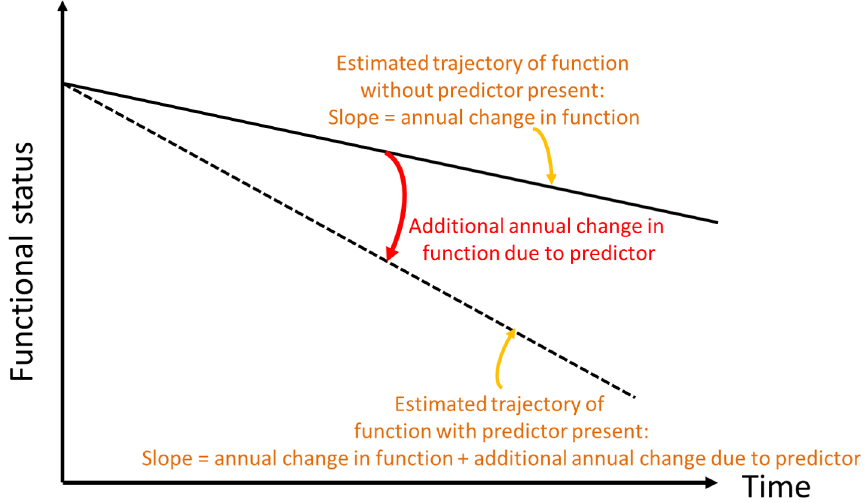
Fig 2. Conceptual depiction of change in slope of functional